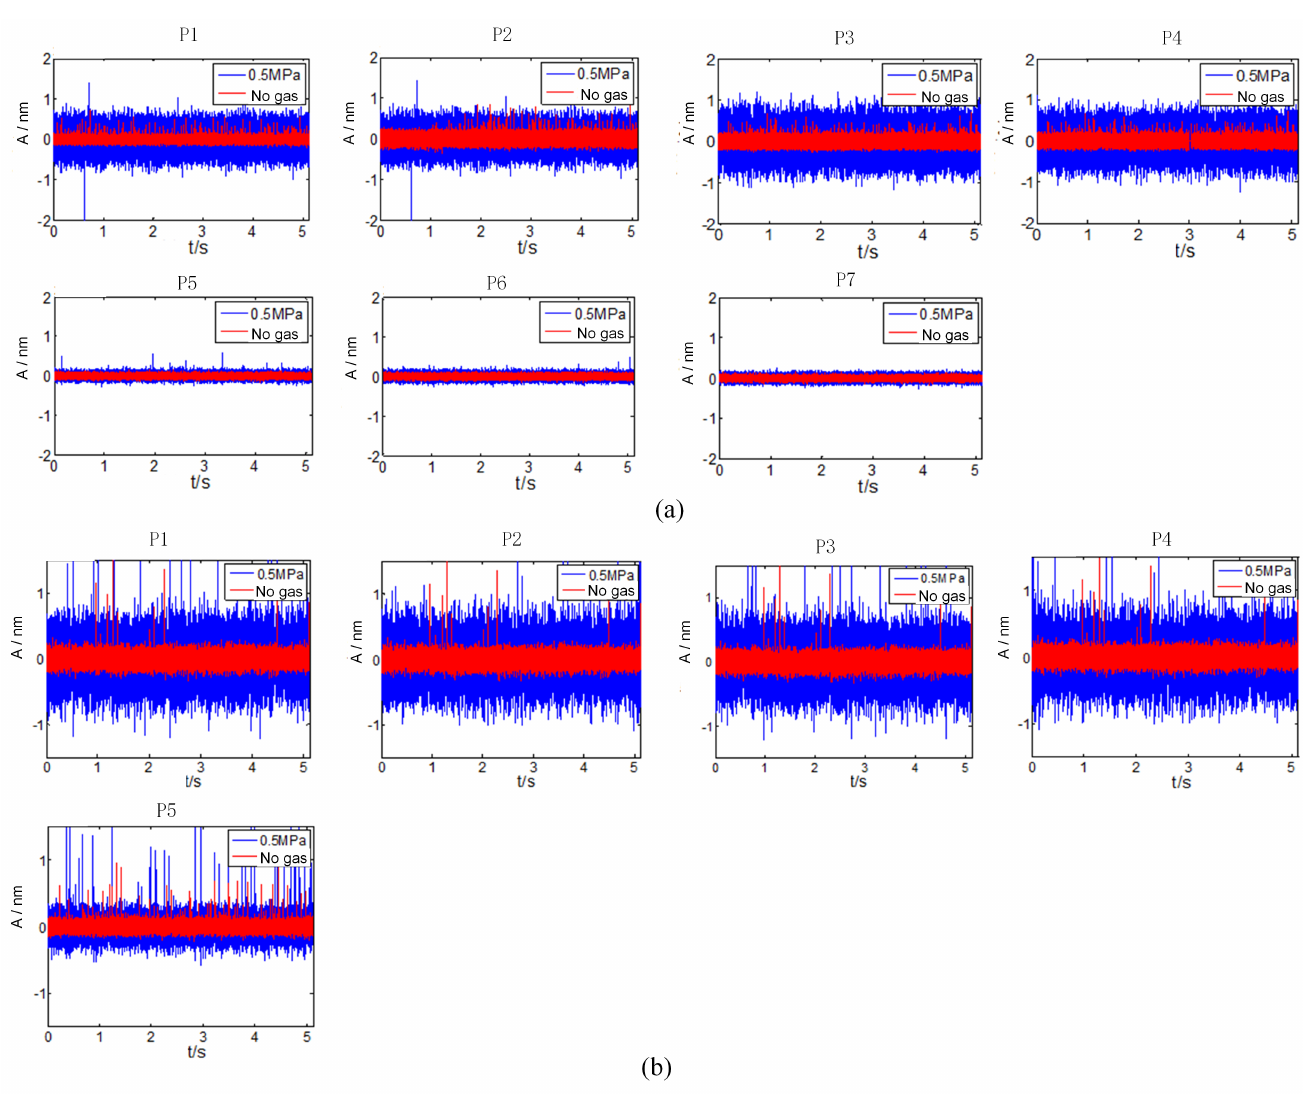
Figure 8. Time-domain vibration data under 0.5 Mpa and no gas: ( a ) double-ring-grooved; and ( b ) double-U-grooved. Table 1. Time-averaged amplitude A a under different air-supply pressures